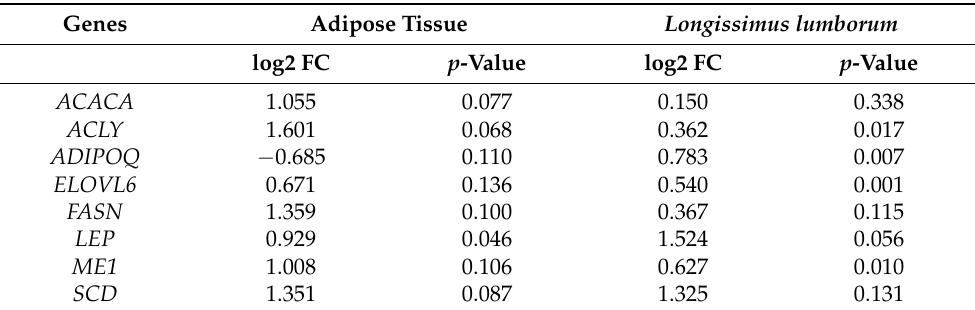
Table 3. Candidate gene expression for lipid metabolism comparison between adipose tissue and indicate overexpression in AL and negative values overexpression in